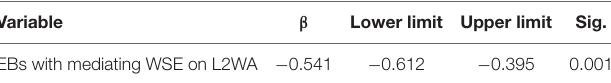
Frontiers in Psychology |